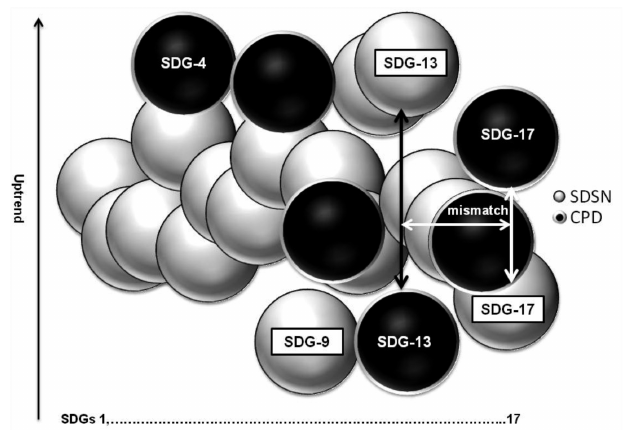
Figure 2. A comparative assessment of the performance by